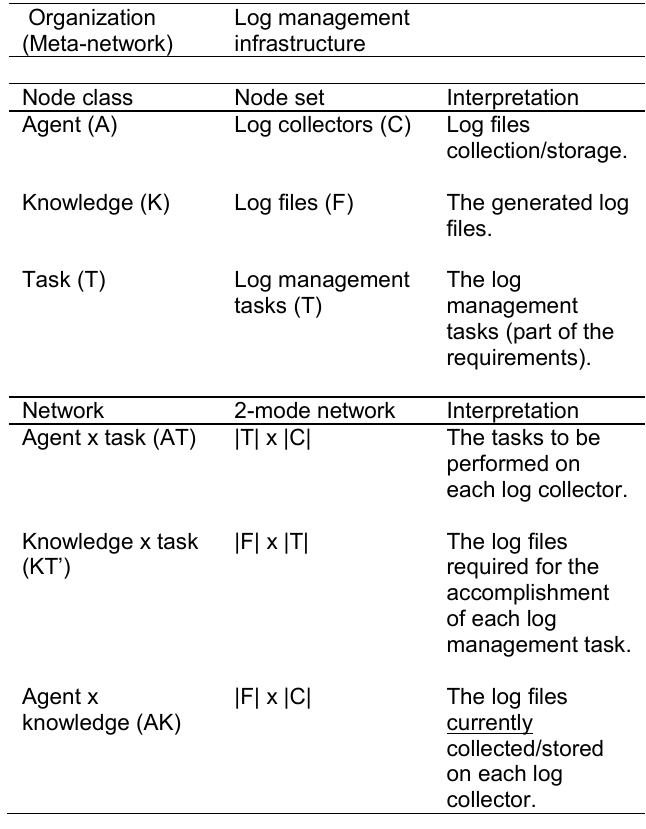
Table 1. Construction of the